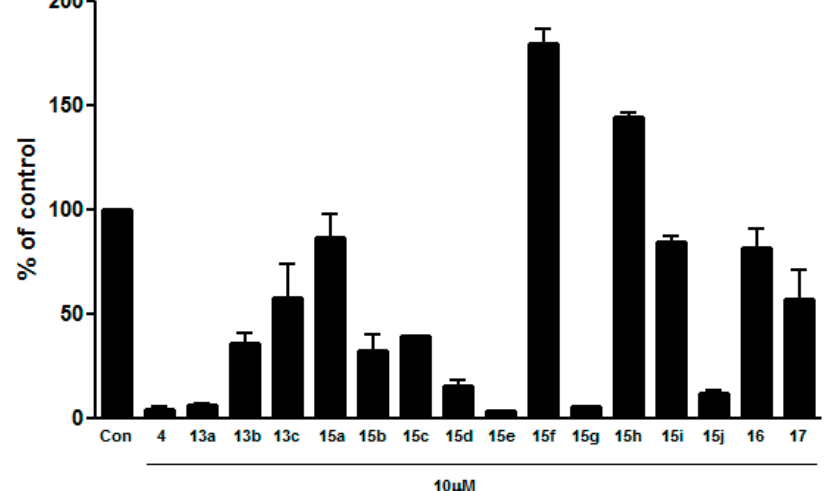
Figure 2. Cell based reporter-gene assay screening of 16 analogs ERR γ binding activity in cell was measured by luciferase activity using co-transfection system with GAL4-ERR γ and pFR-luciferase reporter gene.